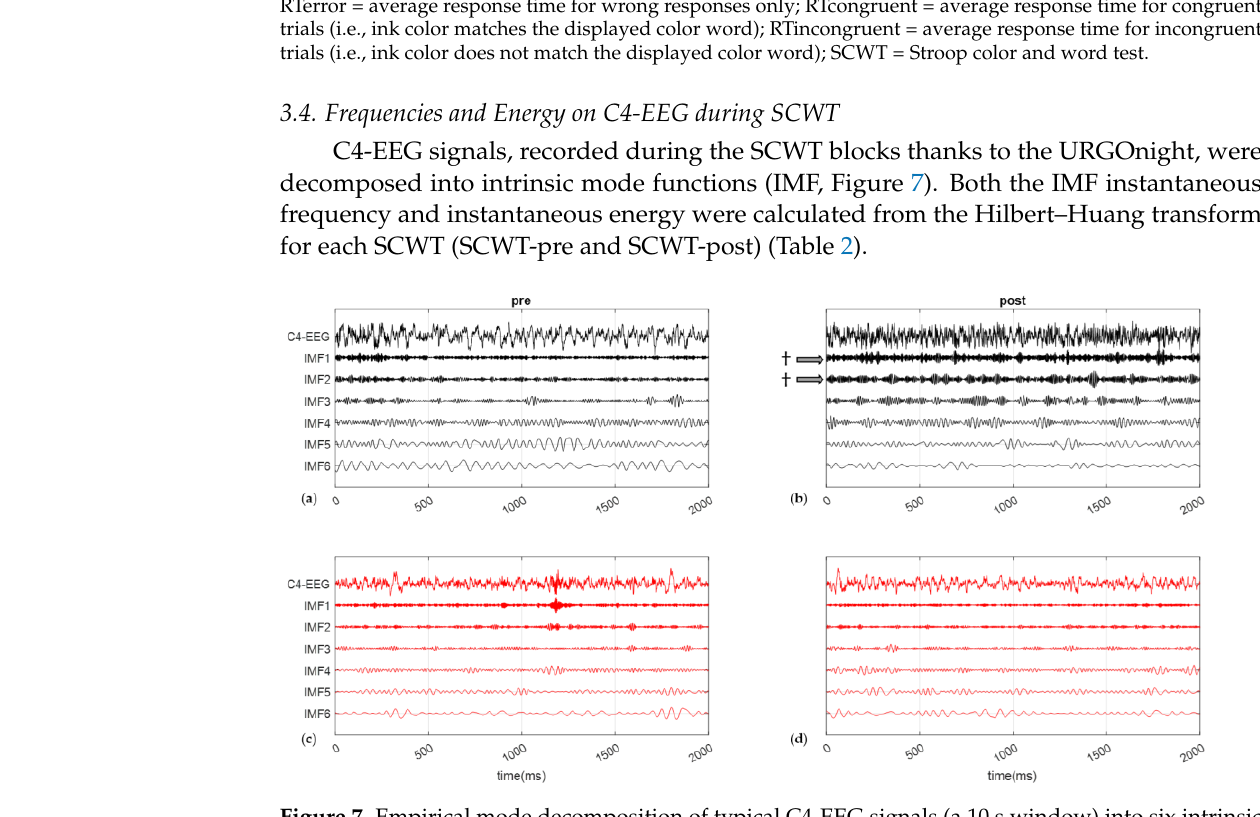
Figure 7. Empirical mode decomposition of typical C4-EEG signals (a 10 s window) into six intrinsic mode functions (IMF). Signal recorded before ( a ) and after ( b ) a control movie for a subject from the Ctrl group and before ( c ) and after ( d ) the SMR-neurofeedback session for a subject from the NFb group. Arrows and † indicate a significant evolution of the magnitude of the associated IMF. Here, the window size of M = 2000 corresponds to a 10 s epoch. Table 2. Means ( ± standard deviations) of frequency and energy values of the six IMFs computed based on the ensemble empirical mode decomposition method [53] conducted on the cerebral activity in the sensory-motor cortex (C4). IMFs were calculated for each group of subjects on pre- and post-NFb training or watching a